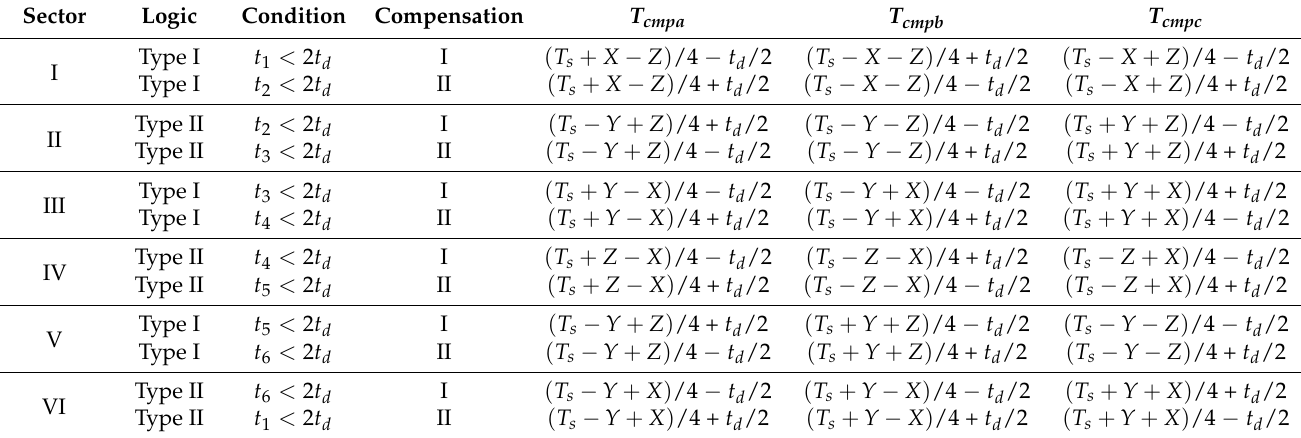
Table 2. Voltage Vector Synthesis Logic and Time under Modified AZSPWM.